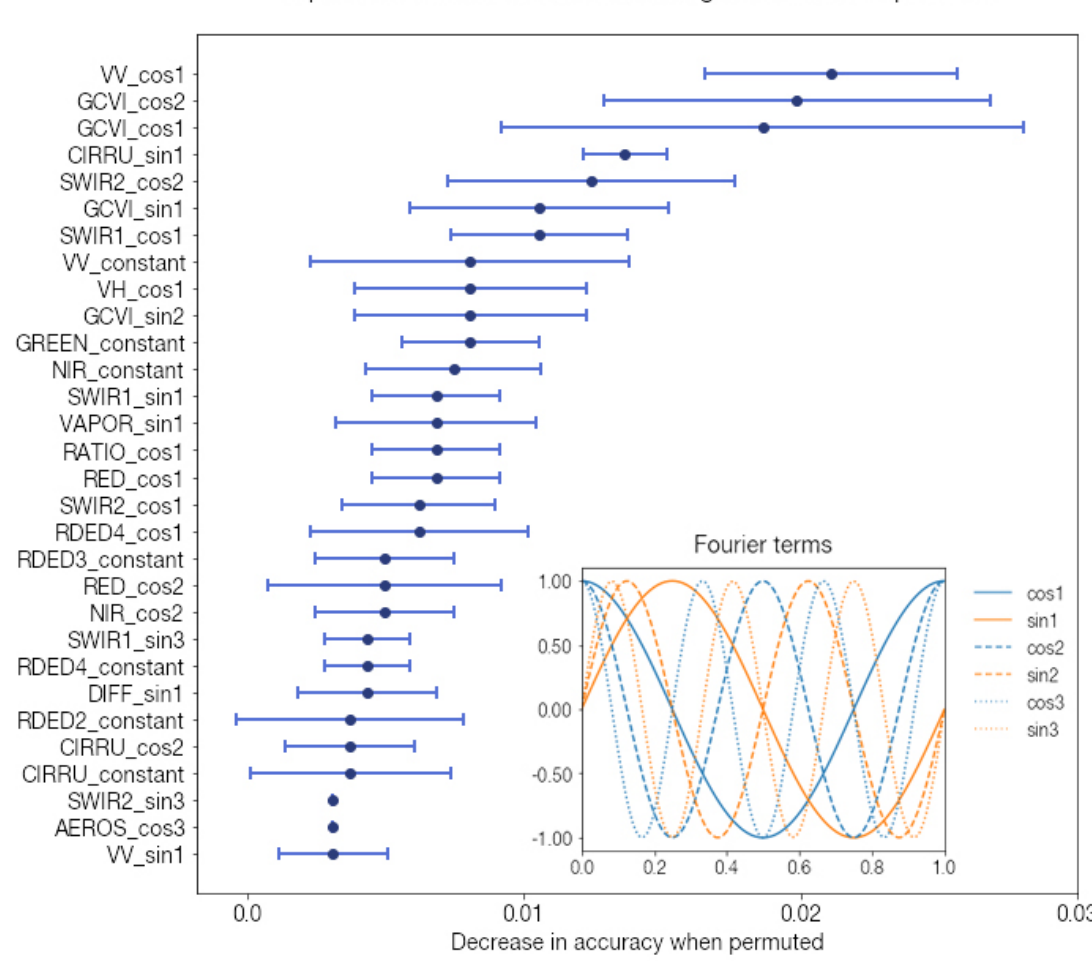
Figure A10. Harmonic coefficient feature importance via permutation. The permutation importance is shown for the 30 most important features. Error bars are 1 standard deviation. Fourier terms are shown in inset for